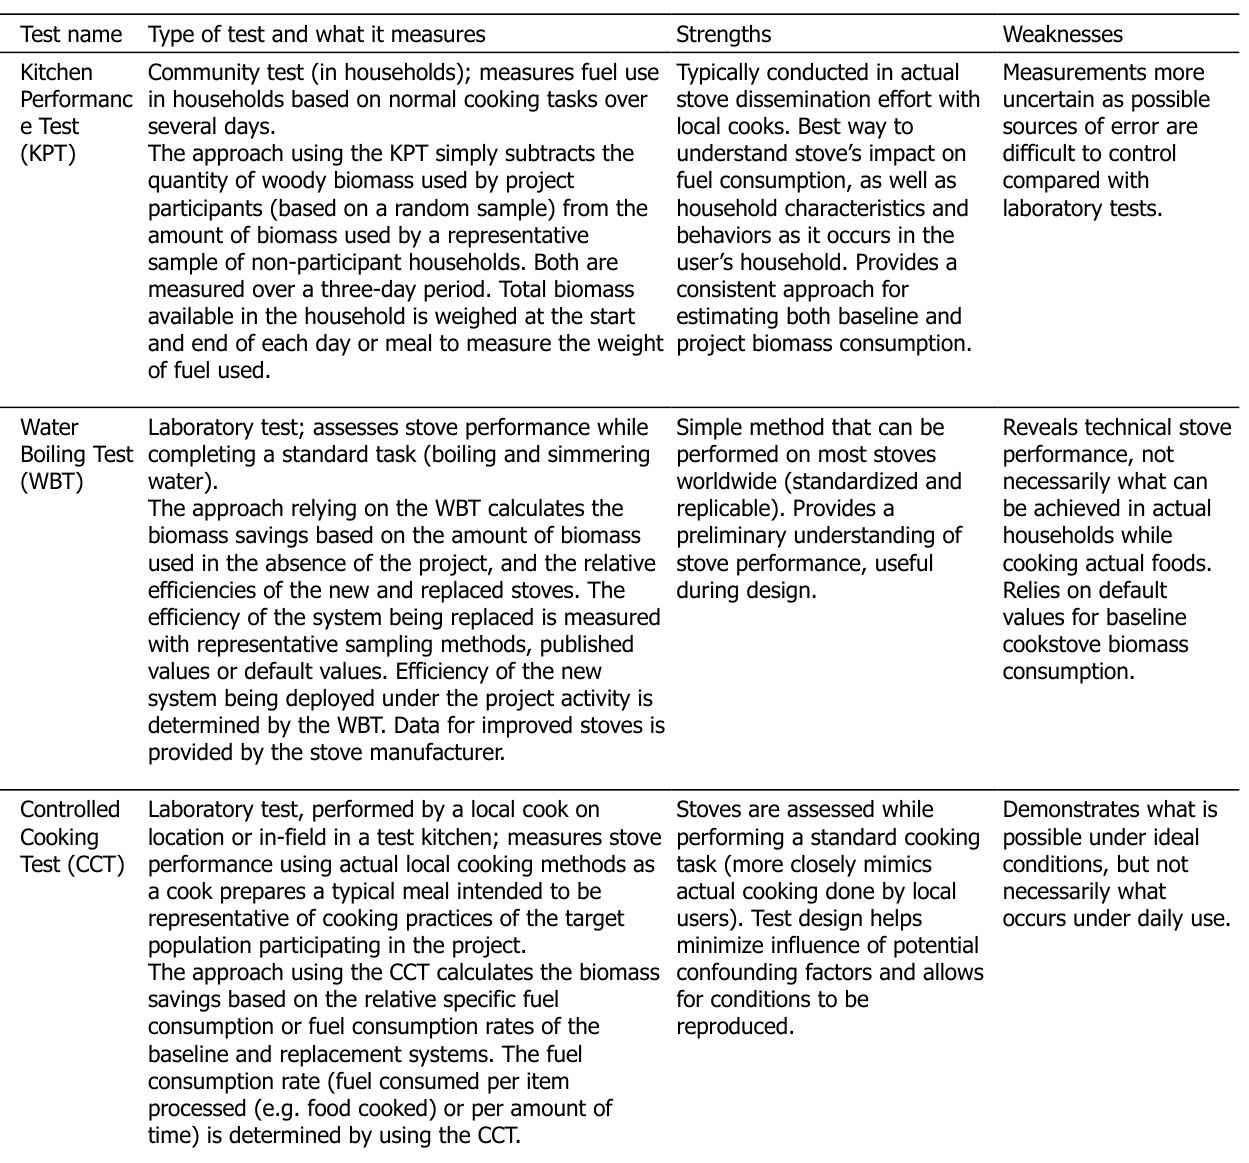
Table 2. Comparison of biomass fuel consumption testing